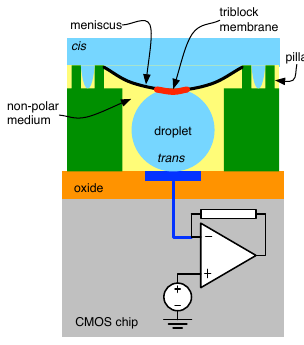
Figure 15. Cross-section of the micro-well with droplet formed trans , as described in